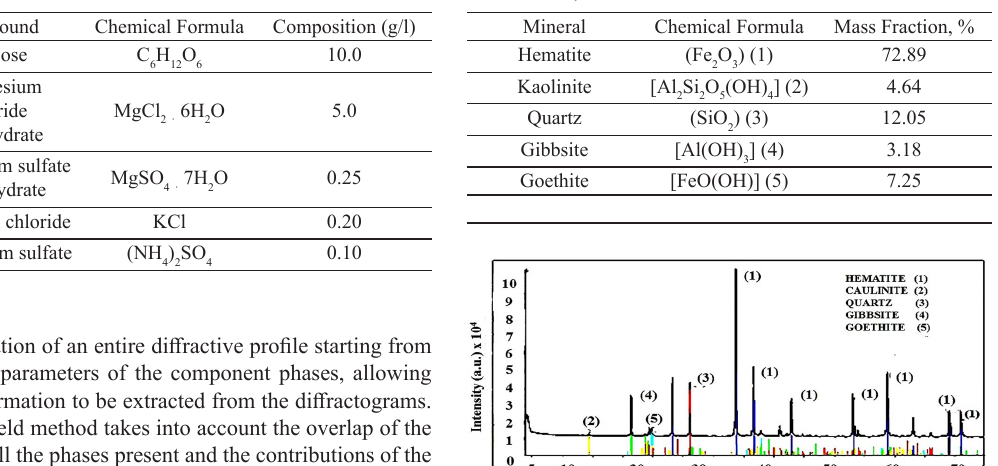
Table 2. Mineralogical composition of the iron ore sample (% by mass